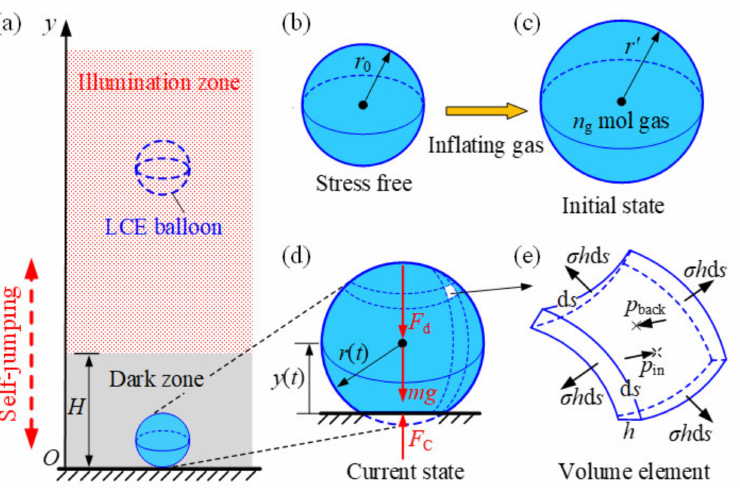
Figure 1. ( a ) Schematics of a self-jumping spherical LCE balloon under steady illumination. The radius r ( t ) of the LCE balloon varies with time because of the light-driven contraction of the LCE membrane. ( b ) Reference state of the LCE balloon in the stress-free state. ( c ) Initial state of the LCE balloon inflated by gas. ( d ) The LCE balloon contacting rigid surface in dark zone is subjected to gravity mg , damping forces F d , and contact force F C . ( e ) Volume element. The LCE balloon can self-jump under steady illumination due to the expansion during contact with the rigid surface in the dark